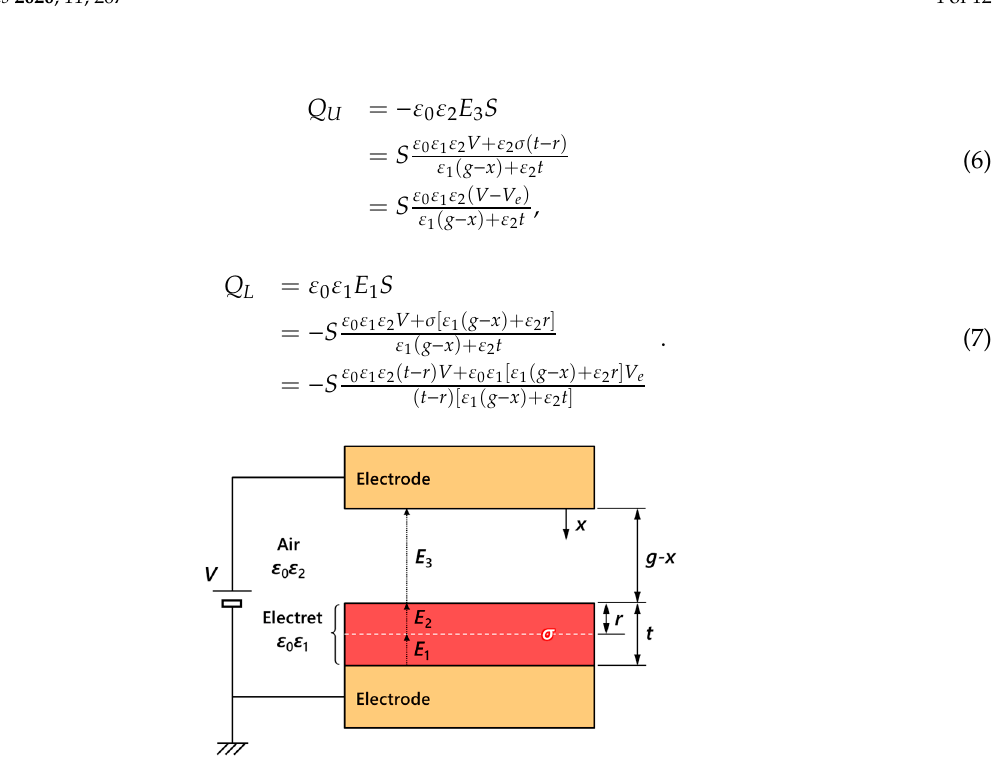
Figure 3. Electrical modeling of gap-closing parallel plate electrodes with electret.